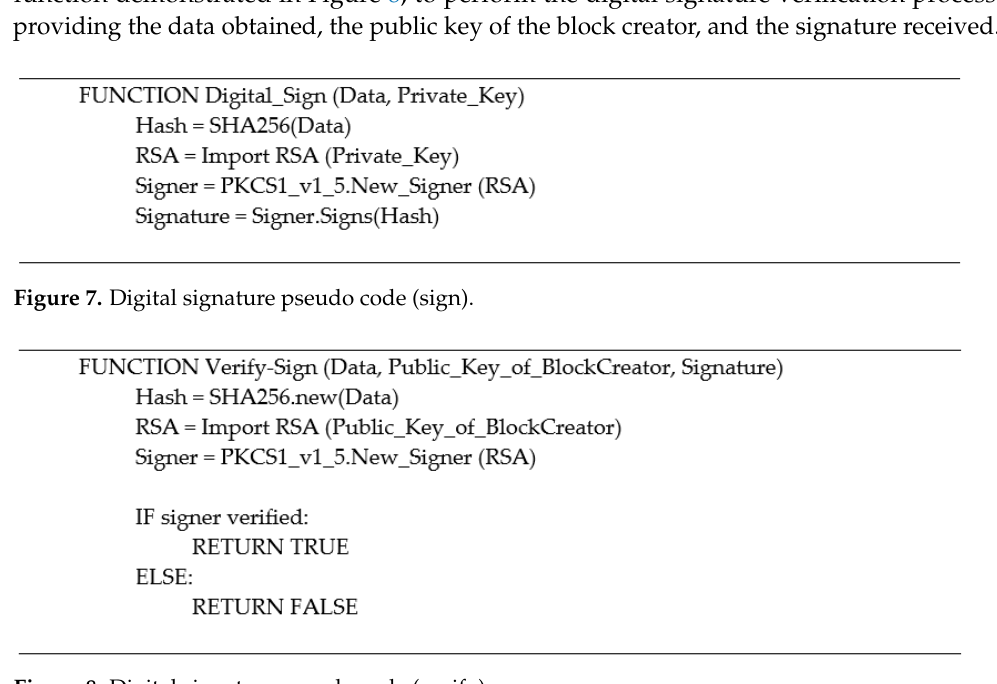
Figure 8. Digital signature pseudo code (verify).